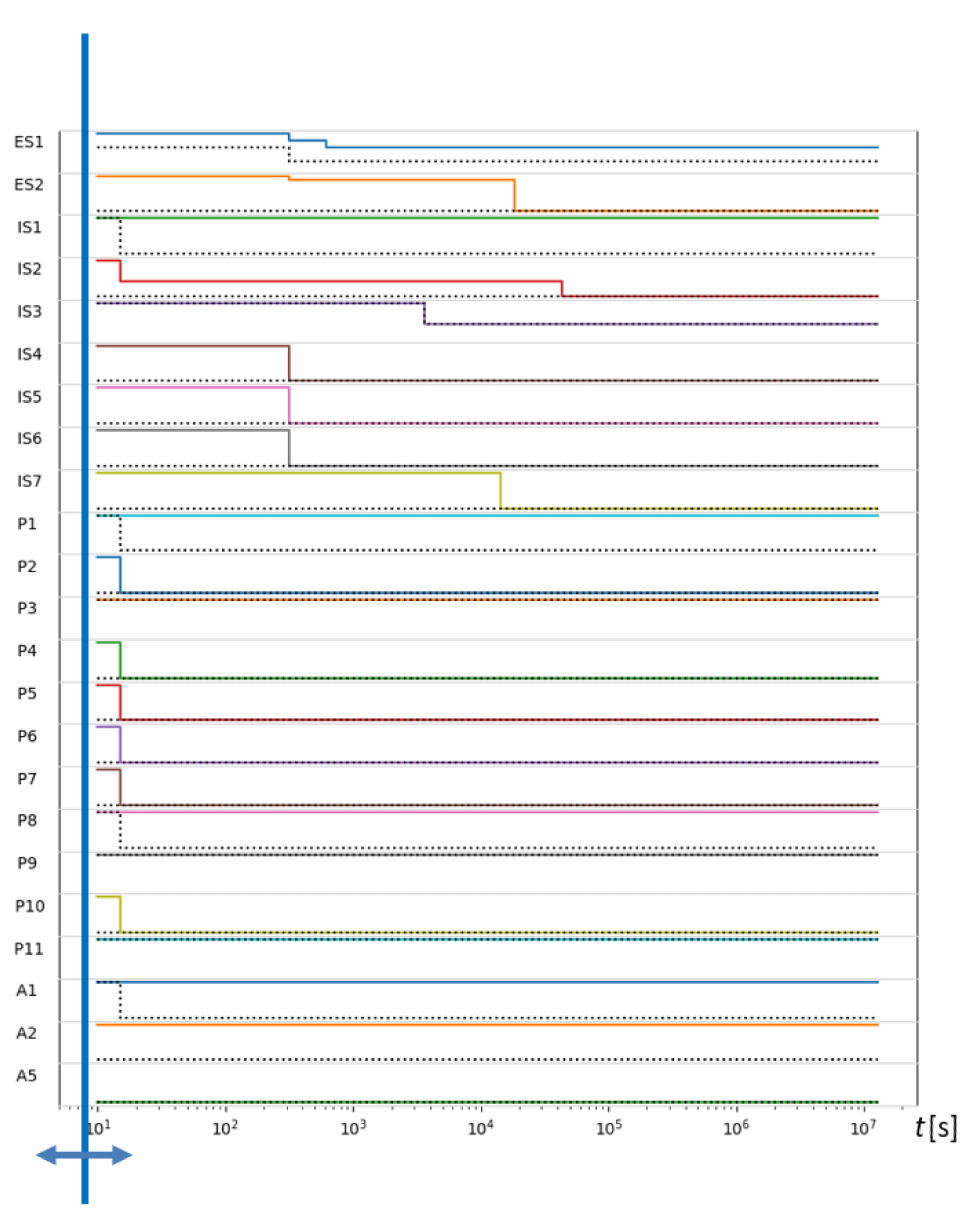
Figure 12. Changes in the object status over